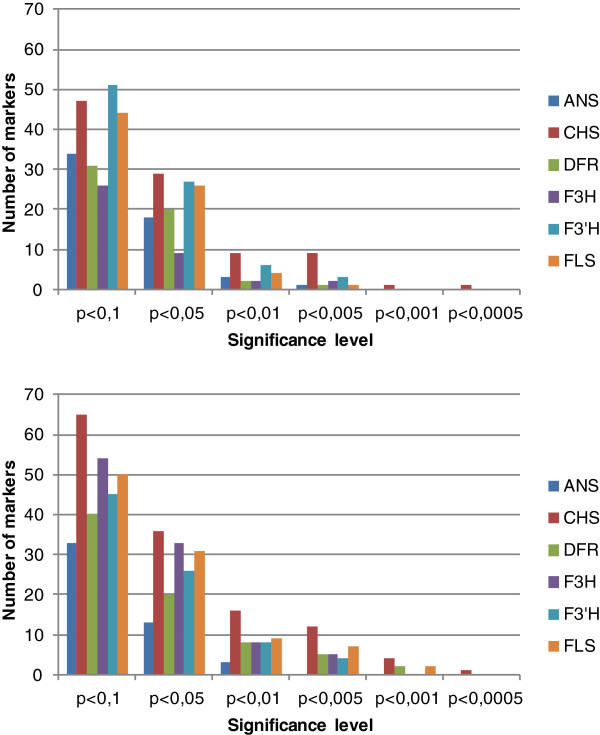
Power analysis by means of Kruskal-Wallis eQTL mapping. Preliminary eQTL mapping by means of Kruskal-Wallis analysis was performed in MapQTL®5 [91]. Two population sizes were compared: 49 siblings (upper panel) and 70 siblings (lower panel). For each gene (ANS, CHS, DFR, F3H, F3′H and FLS) the number of markers (vertical axis) that correlated at a certain significance level (horizontal axis) is given.